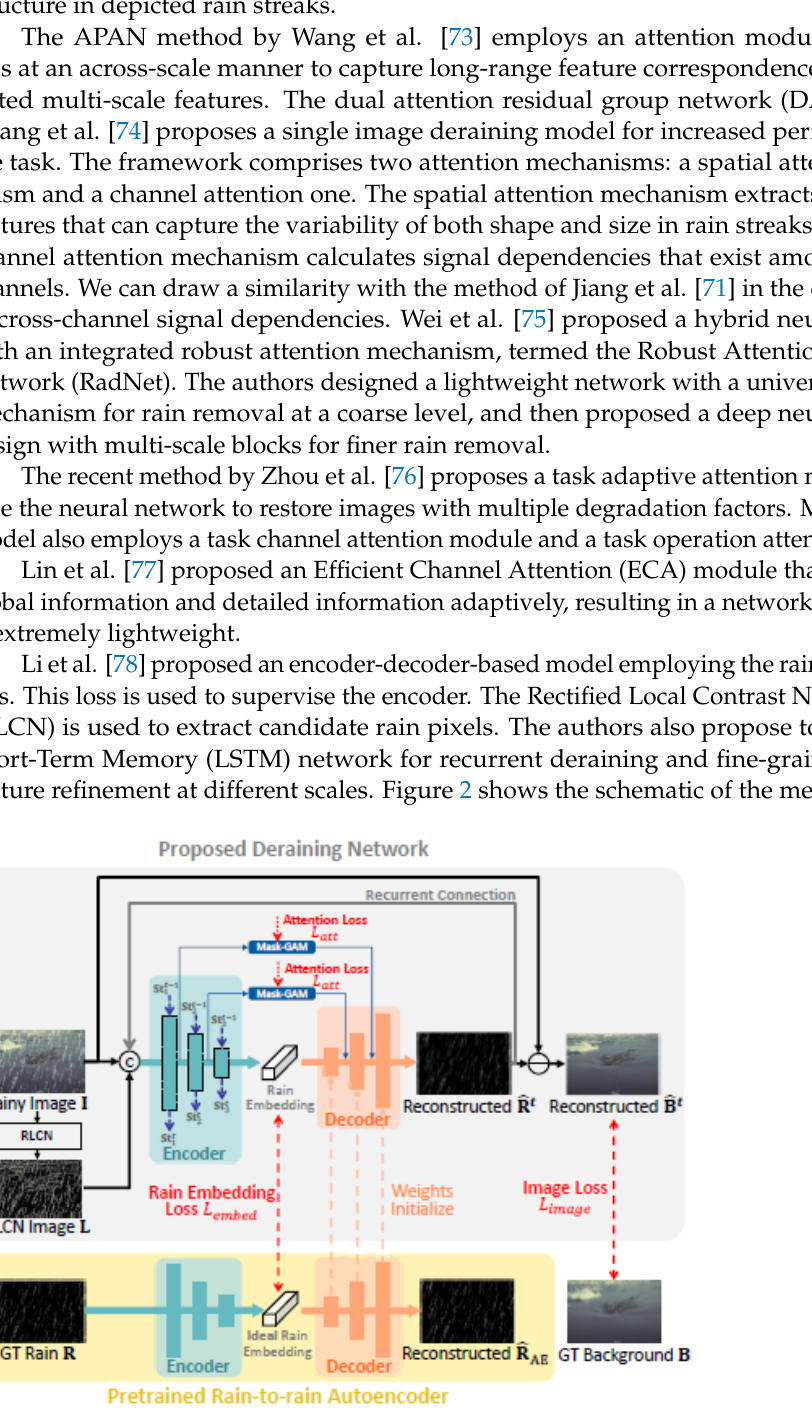
Figure 2. Schematic of the SIR method by Li et al. [78]. The model employs an autoencoder for single image deraining, regularization loss functions and deterministically generated features that encourage the autoencoder to attend to rain streak